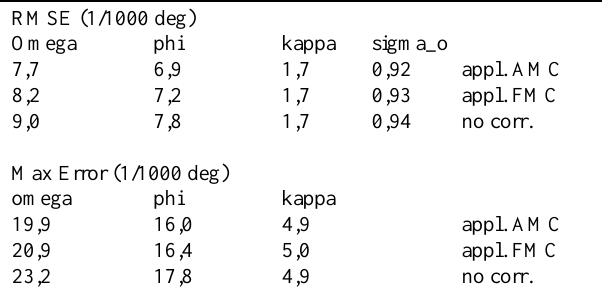
Table 2 : RMS and maximum angular residuals from a large- scale dataset (cf. Figure 10) show the improvement of the AMC technology. The maximum difference of 3,3 (1/1000 deg) at omega Max Error corresponds to 1,9 Pixel in the oblique image. The evaluation of the results from this dataset focuses on overall geometric quality (represented by sigma_o values) and the result of the IMU residuals. Table 2 shows how pose results are improved by correct motion compensation. The quality measures from the roll angle omega are improved by 16% (no correction vs. AMC) and 5% (FMC vs.